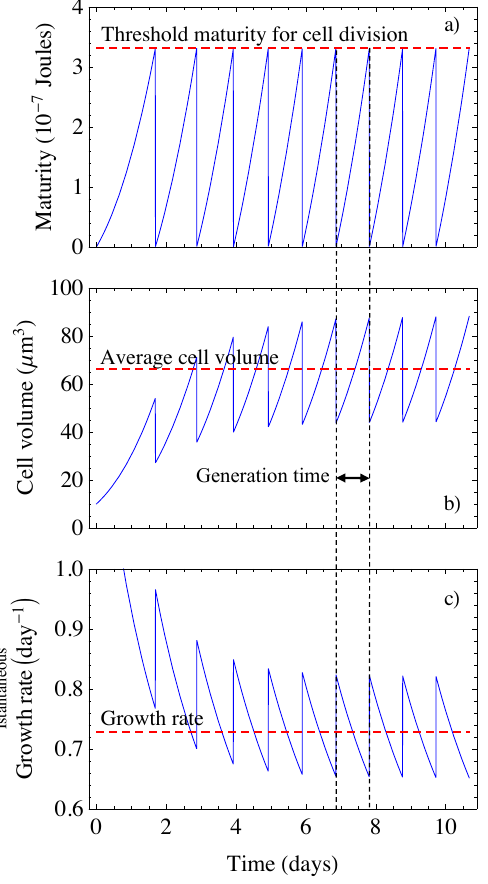
Figure 10. Evolution in time of modelled (a) maturity, (b) cell vol- ume and (c) instantaneous growth rate of a cell undergoing 10 suc- cessive cycles of growth and division. Notes: the horizontal dashed line in (a) represents the threshold value of accumulated maturity in the cell at which cell division takes place, the horizontal dashed line in (b) is the average cell volume when cell cycles attain steady state, and the horizontal dashed line in (c) is the average instantaneous growth rate when cell cycles attain steady state and is numerically equivalent to the growth rate calculated from the generation time (vertical dashed lines) via Eq. (22) – it is conceptually equivalent to the growth rate measured from cell counts in culture